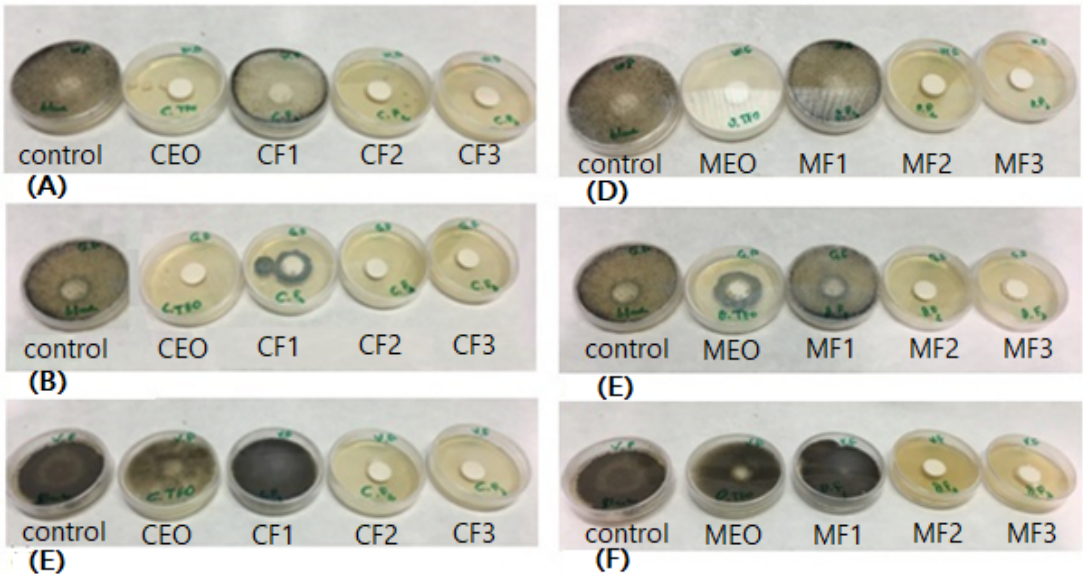
Figure 2. Visual observation of fungal growth inhibition (FGI) of Carum carvi L. essential oil (CEO) and its fractions against ( A ) R. oryzae , ( B ) R. stolonifier , and ( C ) A. penicillioides . FGI of Origanum majorana L. essential oil (MEO) and its fractions against ( D ) R. oryzae , ( E ) R. stolonifier , and ( F ) A. penicillioides . Media after seven days at 27 ± 1.5 °C.